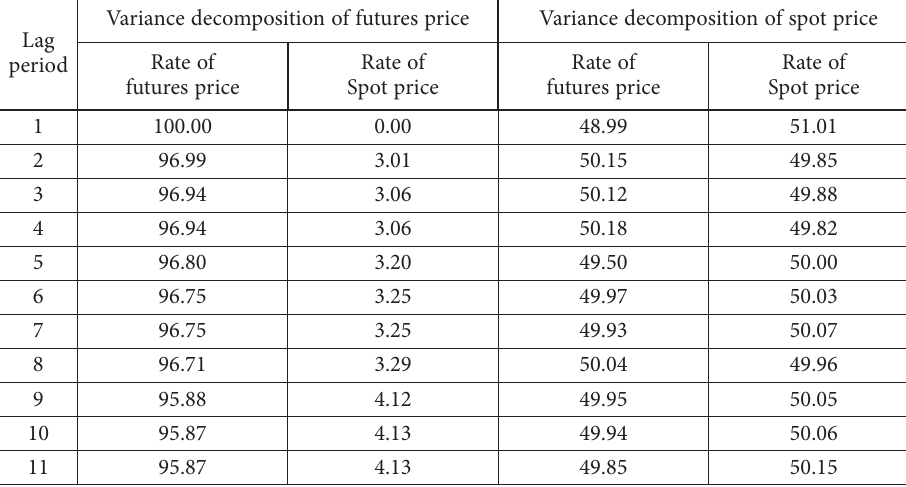
Table 8. Variance factor decomposition of based on VECM Variance decomposition of futures Lag period